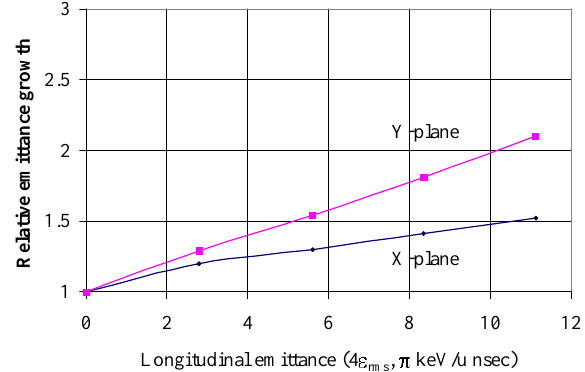
FIG. 5. (Color) Transverse rms emittance growth of a proton beam accelerated through 42 QWRs as a function of longitudinal